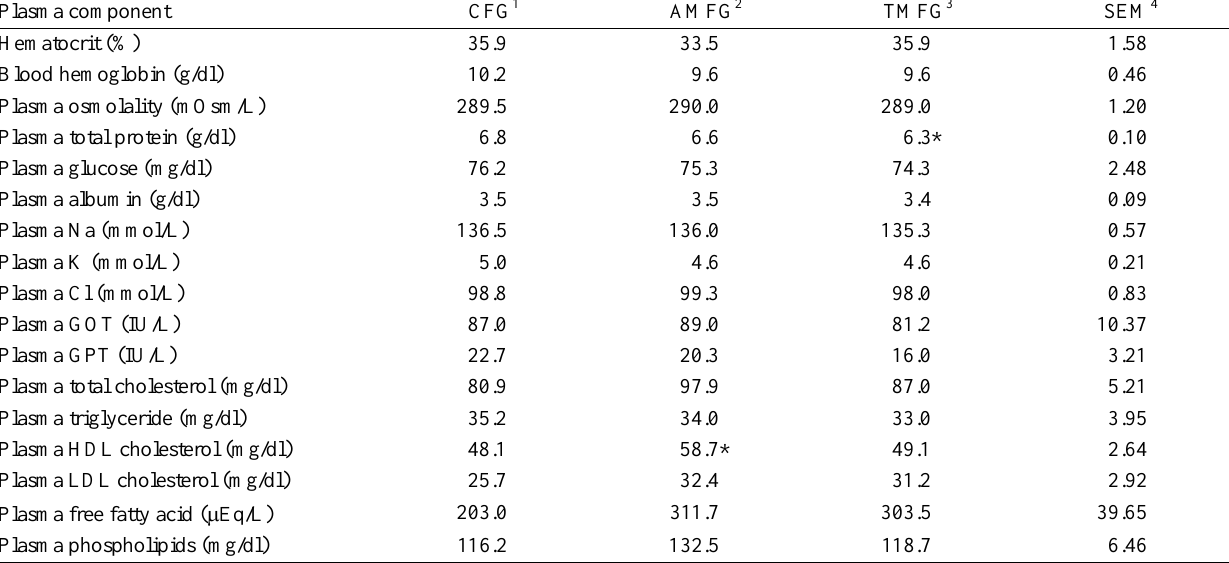
Table 10. Effect of feeding Awamori-pressed lees mixed feed (AMF) and Tofu lees mixed feed (TMF) on blood parameters in female goats Plasma